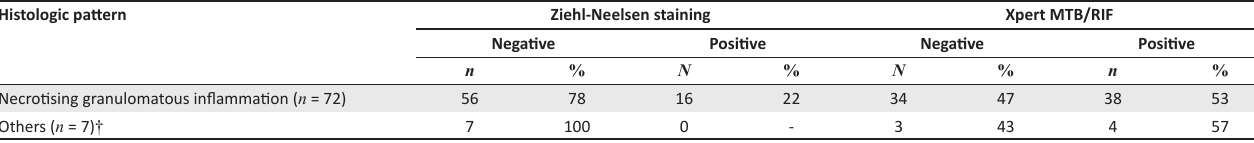
TABLE 2: Yield of Ziehl-Neelsen and Xpert MTB/RIF by patterns of inflammation. Histologic pattern